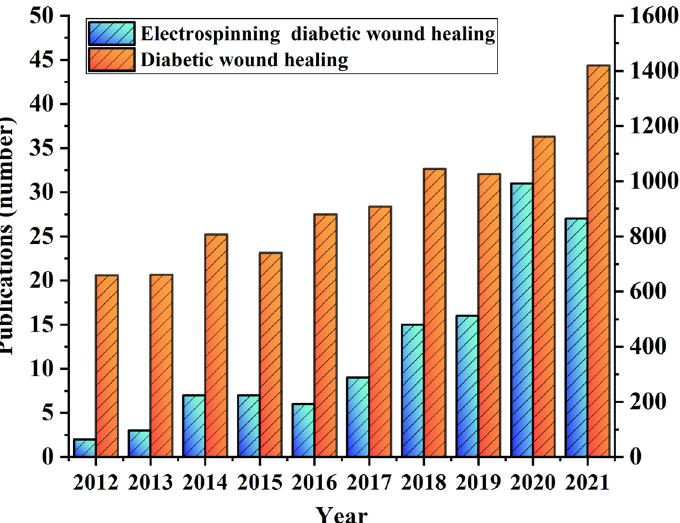
Figure 2. A number of articles published in the field of “Electrospinning diabetic wound healing” and “Diabetic wound healing” on the “Web of Science”, respectively.